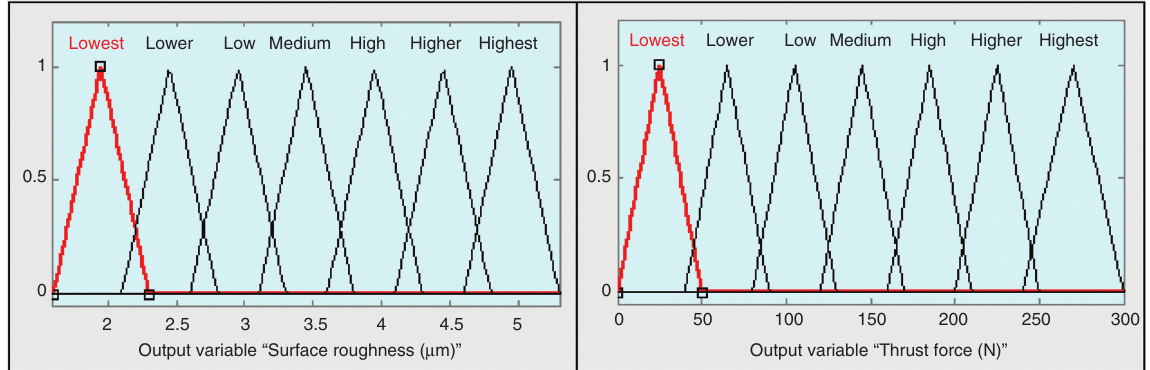
Figure 6 The membership functions and the number range of output parameters.